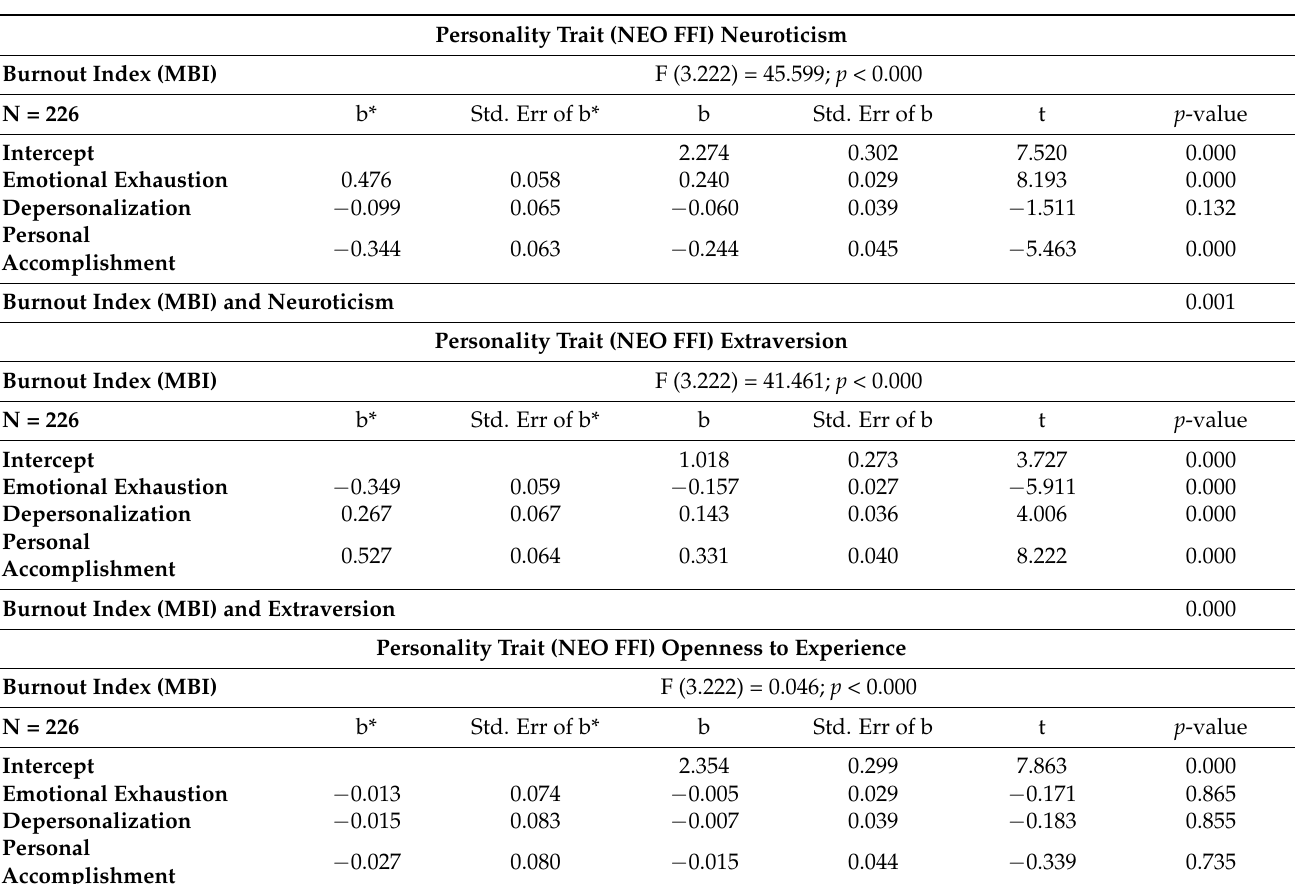
Table 7. Regression between personality traits (NEO FFI) and burnout measure (MBI) in public administration